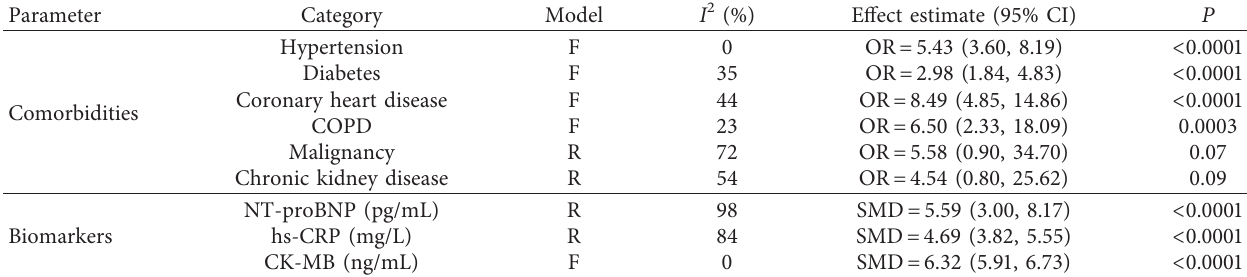
Table 3: Baseline differences between COVID-19 patients with elevated and normal cTn in terms of preexisting comorbidities and the mean values of other cardiac injury biomarkers.